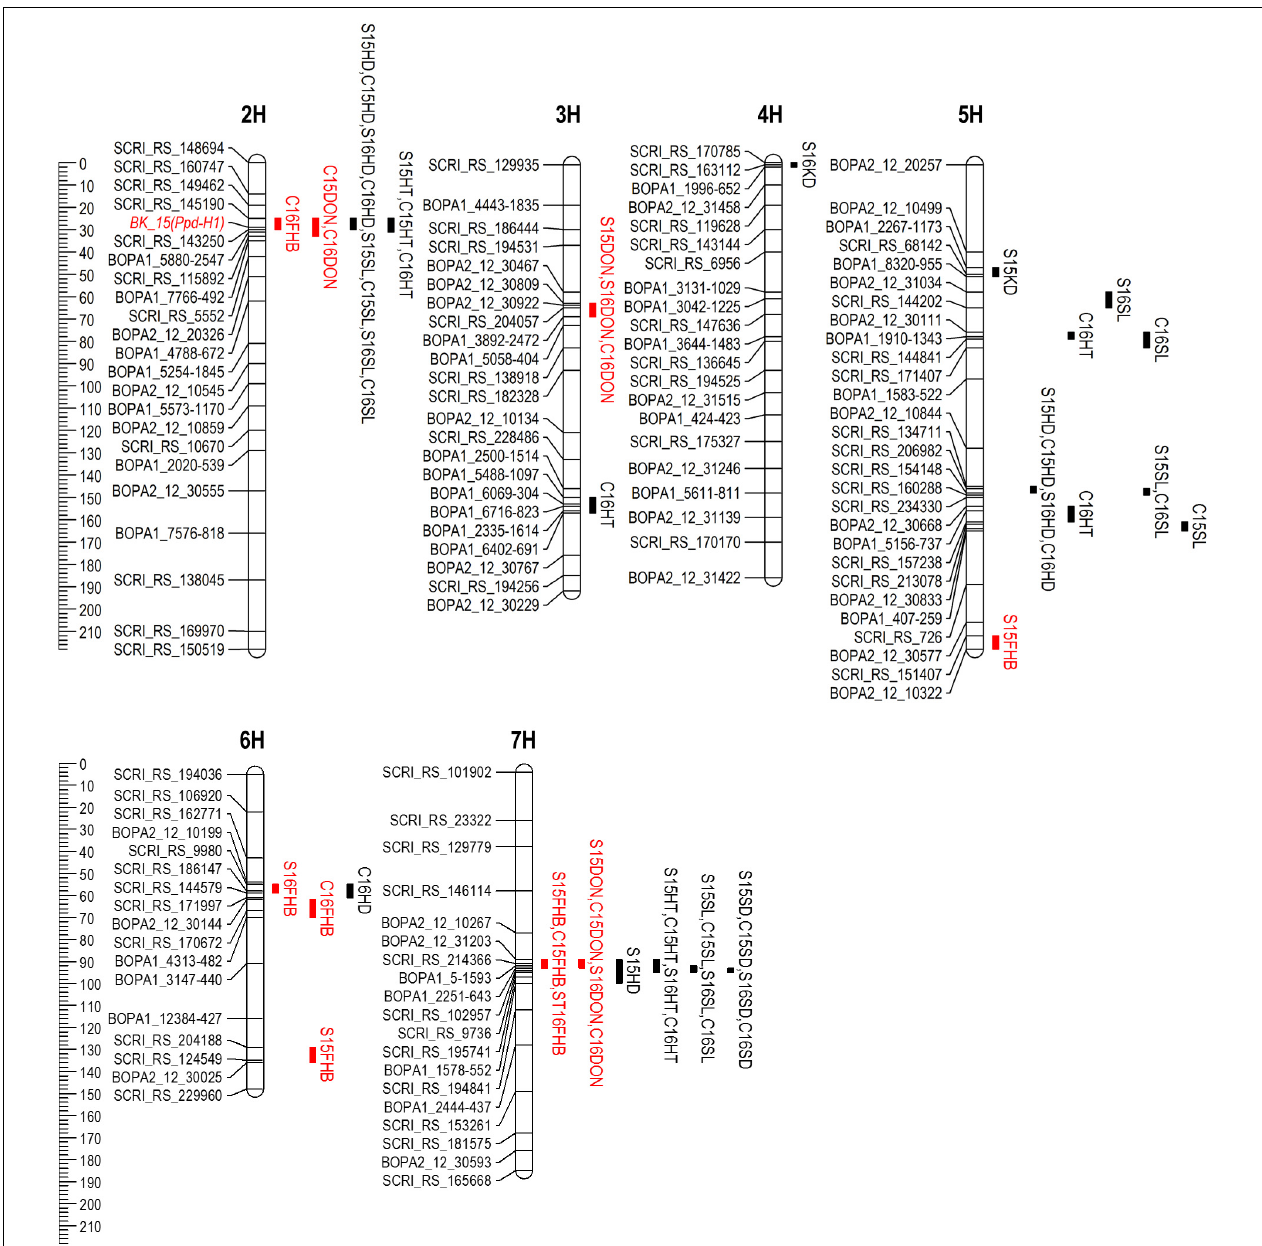
FIGURE 4 | Chromosomal locations of QTL detected for FHB resistance (red), DON accumulation (red) and agro-morphological traits in the Rasmusson × PI383933 recombinant inbred line (RIL) population in four environments. QTL intervals represent one LOD score drop. QTL name is denoted by location (S, St. Paul; C, Crookston), year (2015 or 2016) and trait. FHB, Fusarium head blight; HD, heading date; HT, plant height; SL, spike length; SD, spike